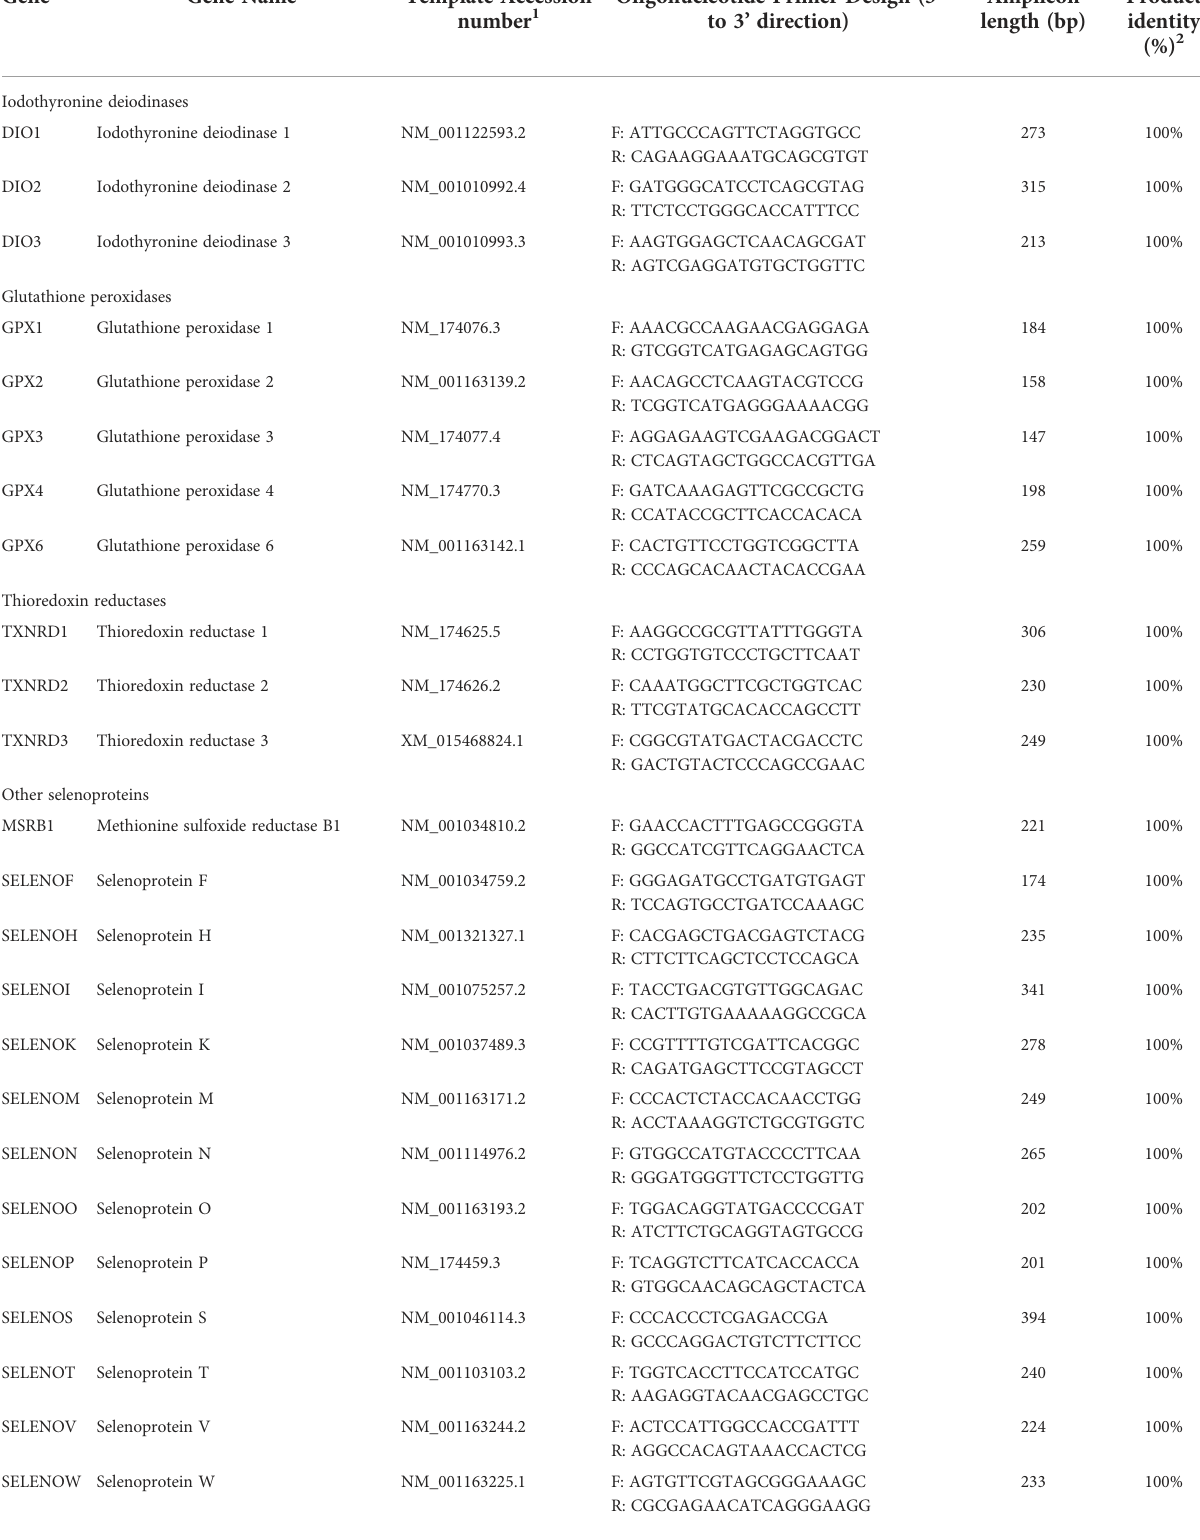
TABLE 1 Primer sets and product identities of real-time RT-PCR analysis of reference and selenoprotein-associated